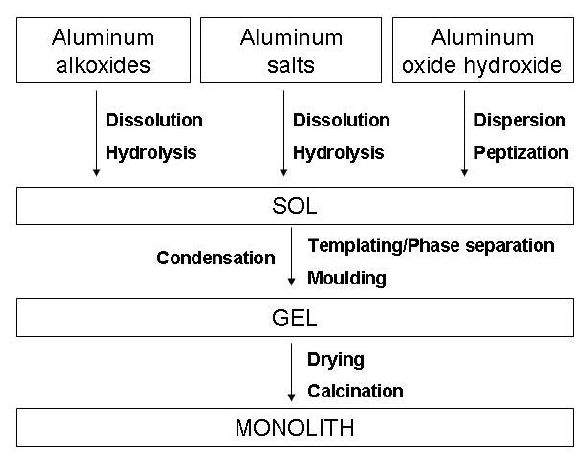
Figure 4. The Sol-gel alumina monolith preparation